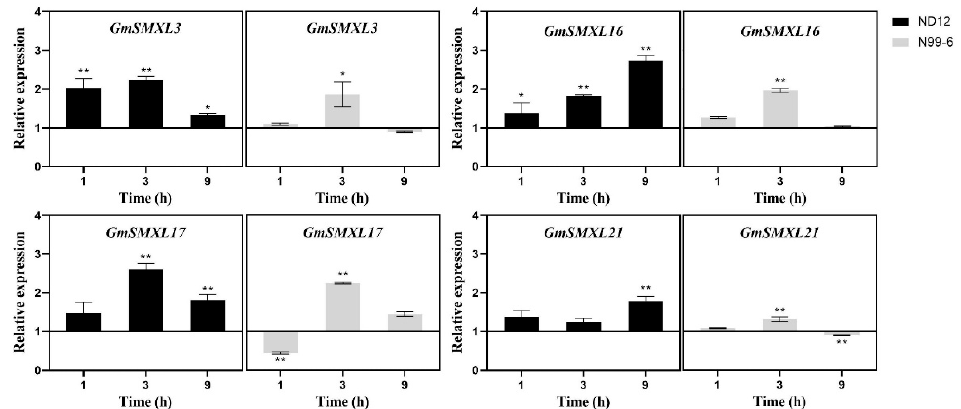
Figure 10. The expression levels of GmSMXL genes in ND12 and N99-6 relative to their normal light treatment after 1, 3, 9 h GR24 (20 µ M) treatment. The values referred to the mean ± standard error (SE) of three independent biological replicates. Asterisks manifested the corresponding genes significantly up- or down-regulated compared with those in normal light treatment. (* p < 0.05, ** p < 0.01, Student’s t -test).